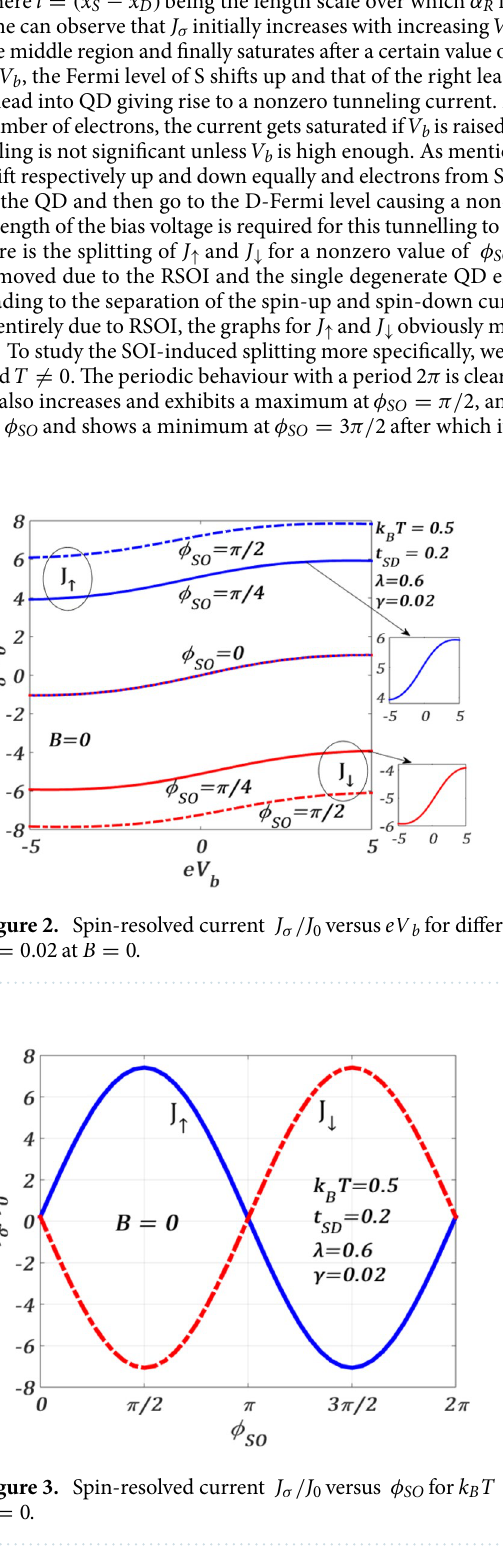
Figure 3. Spin-resolved current J σ / J 0 versus φ SO for k B T 0 B =